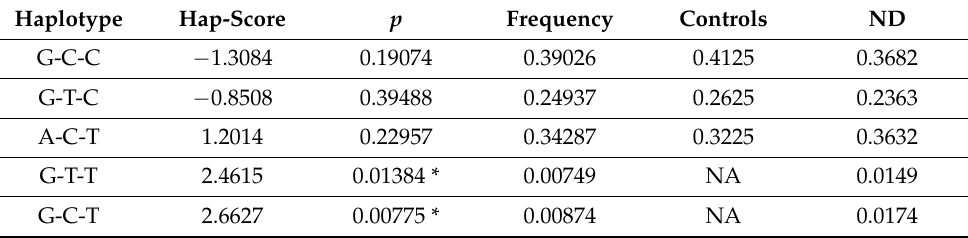
Table 4. Haplotypes frequencies of rs16969968, rs578776, and rs1051730 in the group of nicotine- dependent (ND) subjects and controls.